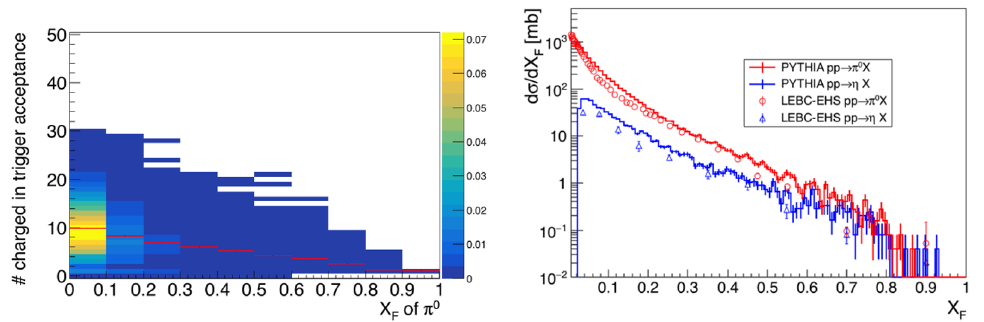
Figure 3 . Left: number of charged particles in the acceptance of the trigger chambers in the LEBC-EHS experiment as a function of the Feynman X F of a co-emitted (cid:25) 0 meson, as evaluated using a PYTHIA simulation: the red line indicates the average values for each X F bin. Right: data-MC comparison of the di(cid:11)erential cross-section of neutral pions and (cid:17) mesons produced from 400 GeV protons, after accounting for the trigger e(cid:14)ciency in the LEBC-EHS setup. At 400 GeV beam energy, the PYTHIA predicted yield is higher than the data